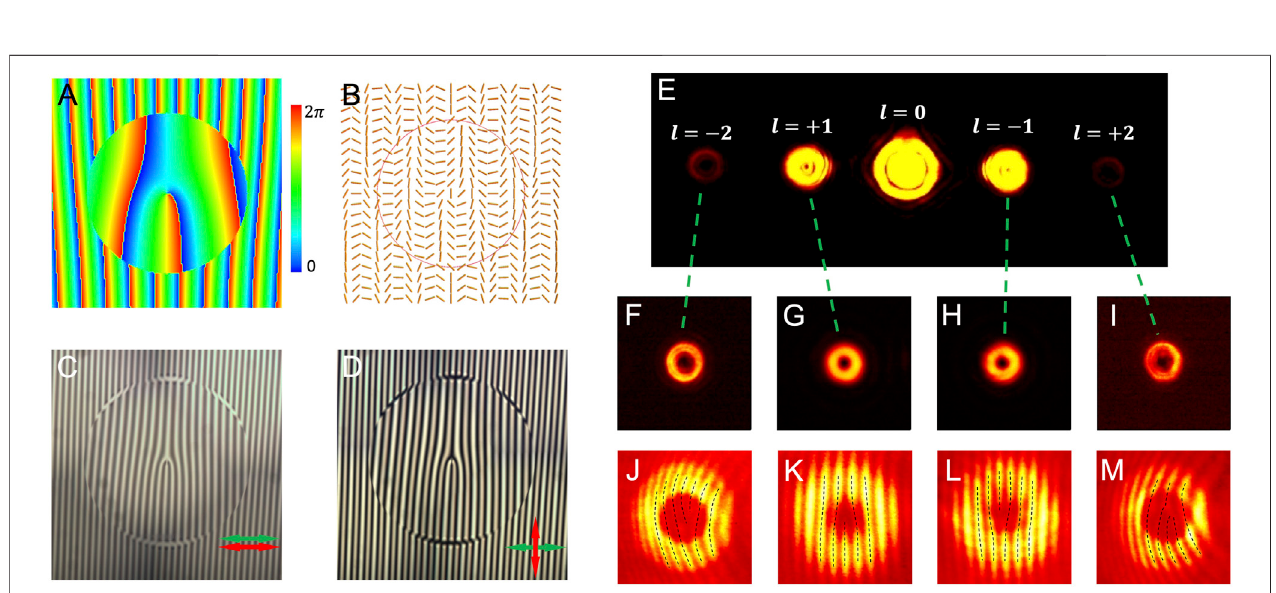
FIGURE 4 | (A – C) Phase pro fi les of vortex, zero-order BG, and fi rst-order BG beams. (D – F) Local optical axis distributions of expected PB phase devices correspondingtothephasepro fi lesinthe fi rstcolumn. (G – I) Polariscopicanalysisresults. (J – L) Experimentalintensitiesobtainedbyusingthesamplescorrespondingto (G – I) . (M) Intensity recorded when the vortex (G) and zero-order BG (H) generators are cascaded to get the fi rst-order BG.